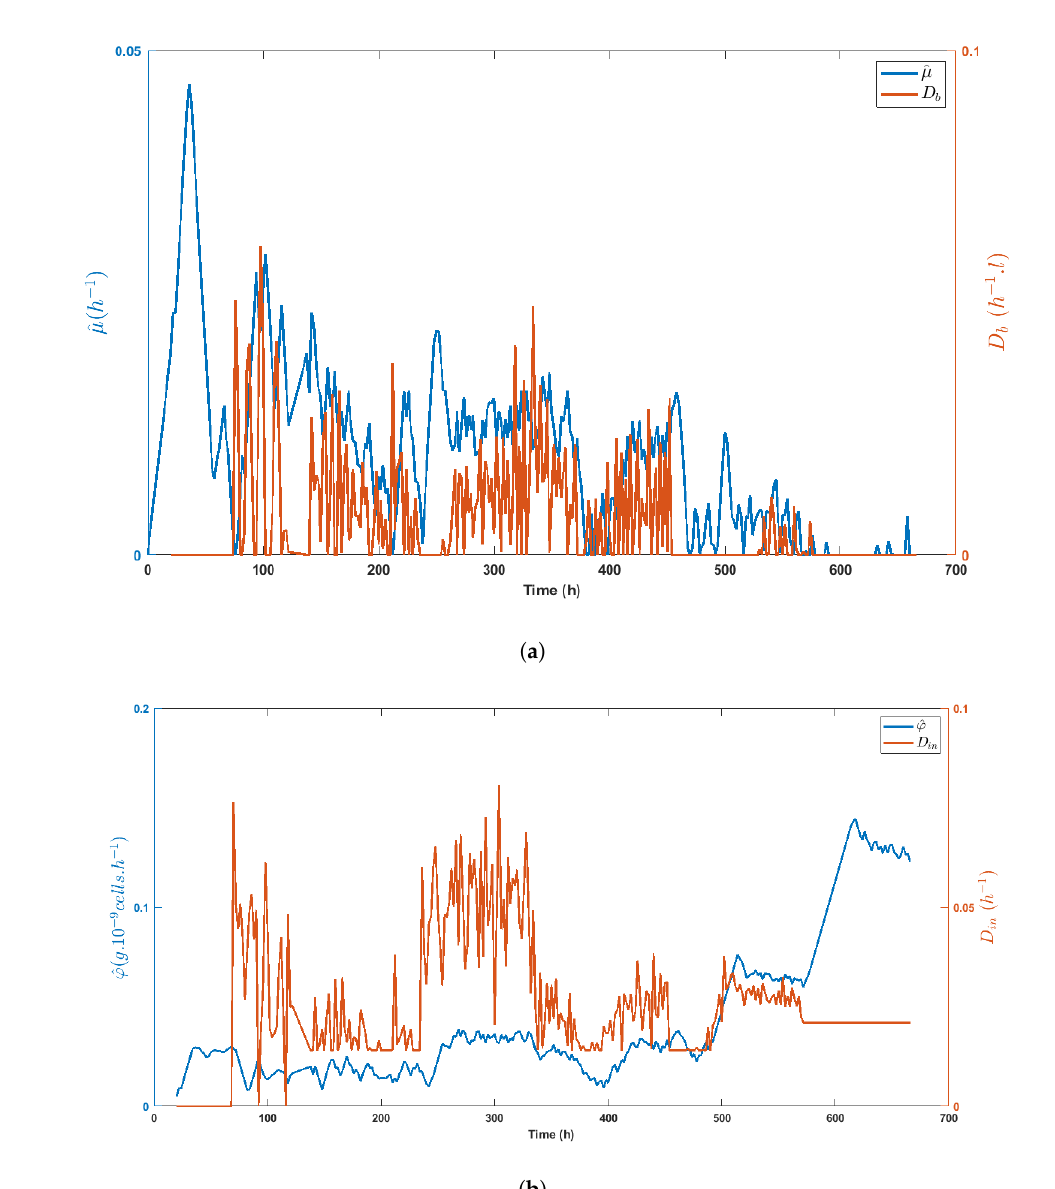
Figure 8. Time evolution of the specific growth rate estimate ˆ µ as compared to the bleed rate D b ( a ) and the time evolution of the specific glucose uptake rate estimate ˆ ϕ as compared with the total dilution rate D in ( b ), stressing the correlation between